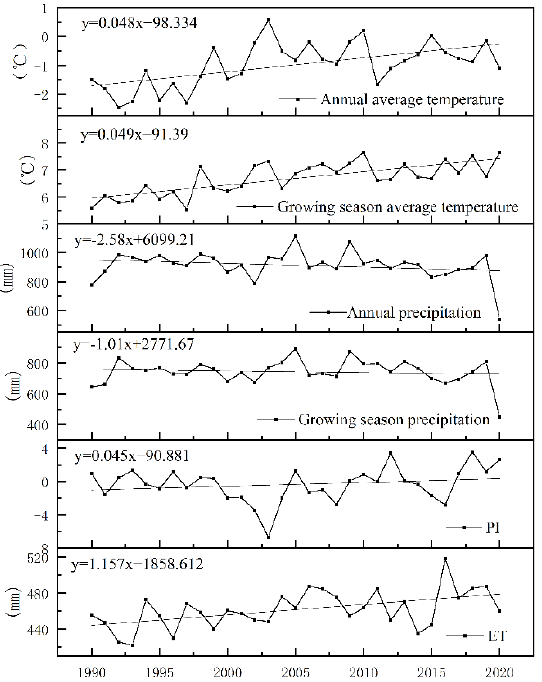
Figure 12. Trends of the climate factors in the Maqu wetlands from 1990 to 2020.